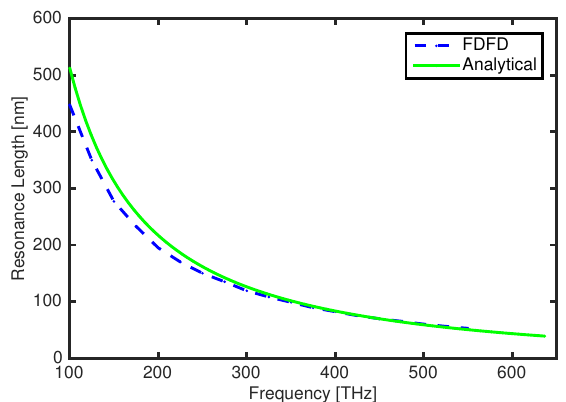
Figure 4: Resonance length of a gold-based plas- monic nano-antenna as a function of frequency (ra- dius a =5